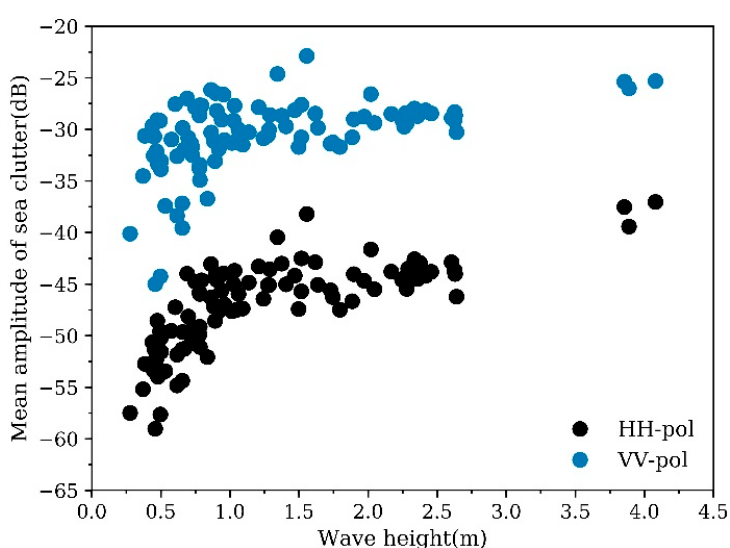
Figure 10. The mean value of different polarized sea clutter amplitudes in the X-band of the Yellow Sea varies with wave height.